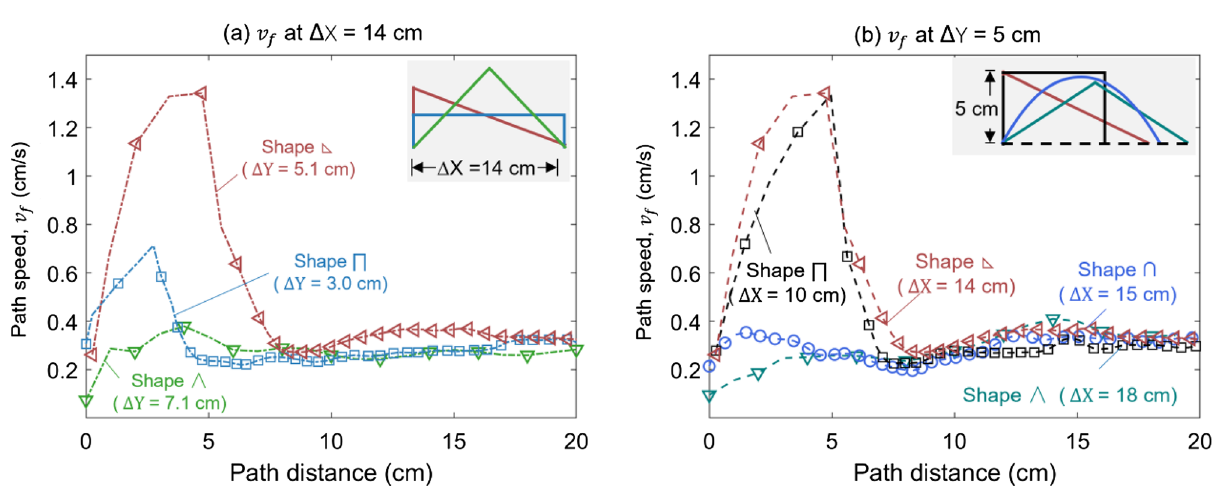
Figure 7. The path speed ( v f ) for different path shapes ( a ) under the same horizontal span (∆X = 14 cm) and ( b ) under the similar path height (∆Y = 5